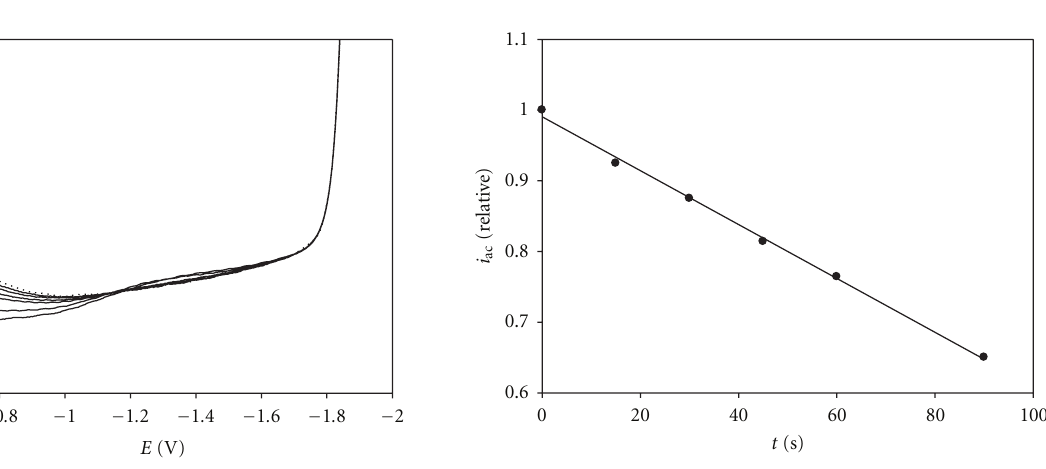
Figure 5: i ac - E curves for a sample of Drava river with increasing deposition times from 0s (dotted line) to 120 s. Deposition potential was − 0.6 V, amplitude 10mV, frequency 75Hz. 0.55 M NaCl was added to the sample.